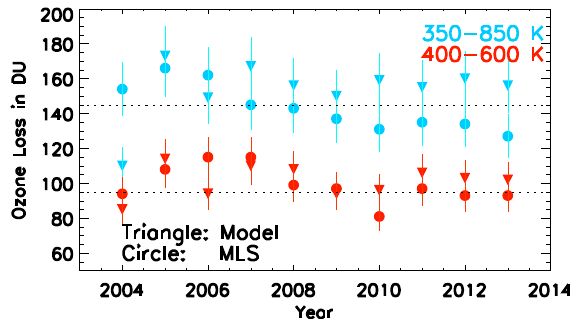
Figure 6. Vortex-averaged (defined by ≥ 65 ◦ EqL) column ozone loss computed from the MIMOSA–CHIM model simulations and MLS measurements, during the maximum ozone loss period in the Antarctic, at 350–850K and 400–600K for the 2004–2013 period. The estimated uncertainty of the column loss computed from both simulations and measurements is about 10% (e.g., Kuttippurath et al.,